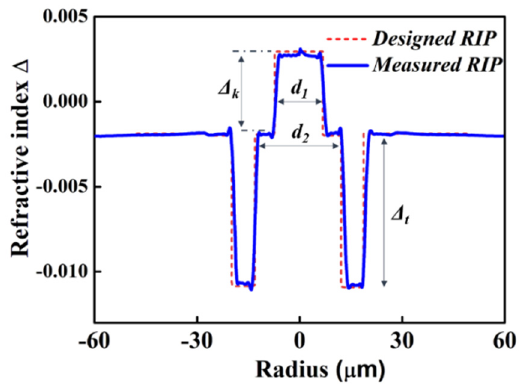
Figure 1. Designed and measured refractive index profile of MSI 2-LP-mode fiber.